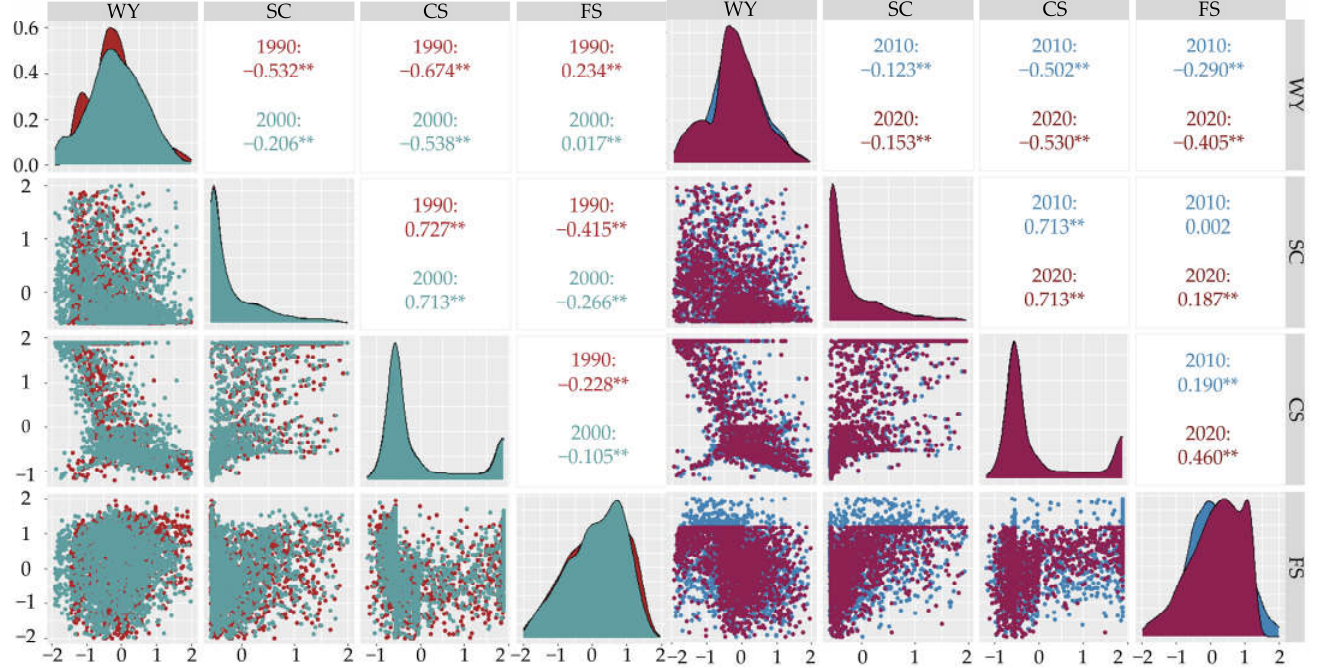
Figure 8. Correlation of ecosystem services in the Yellow River Basin (Henan section). Note: ** at the 0.01 level (two-tailed), the correlation was significant. WY, SC, CS and FS represent the functions of water production, soil conservation, carbon storage and food supply, respectively.